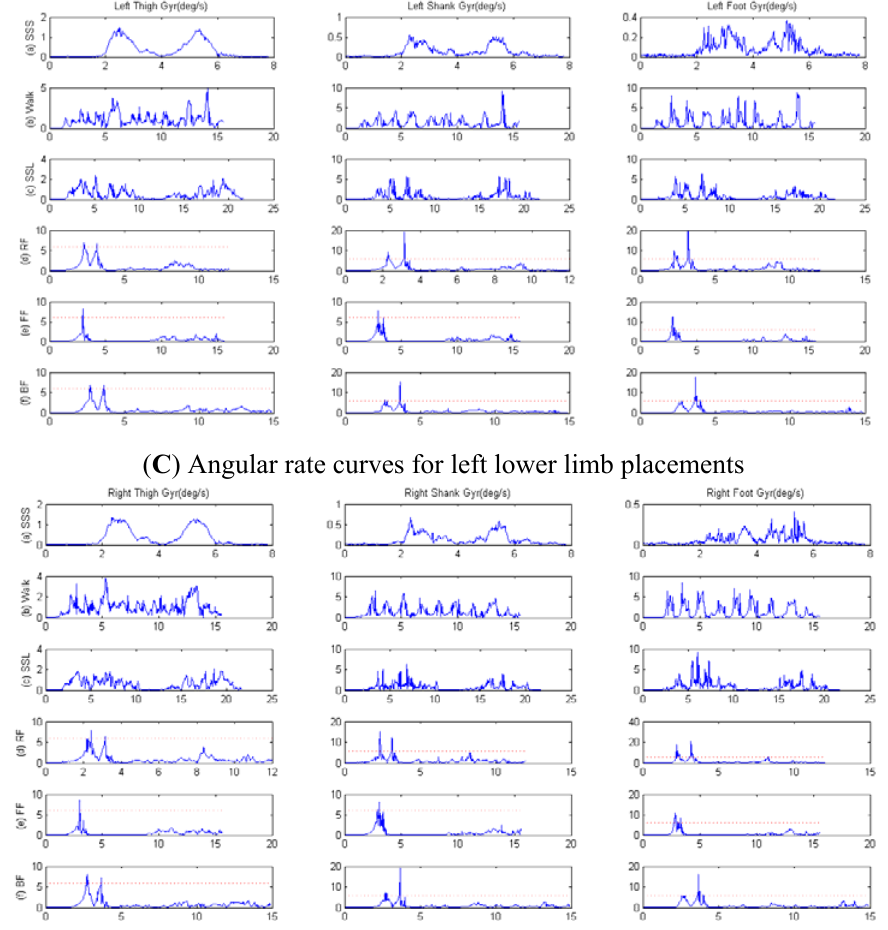
( D ) Angular rate curves for right lower limb